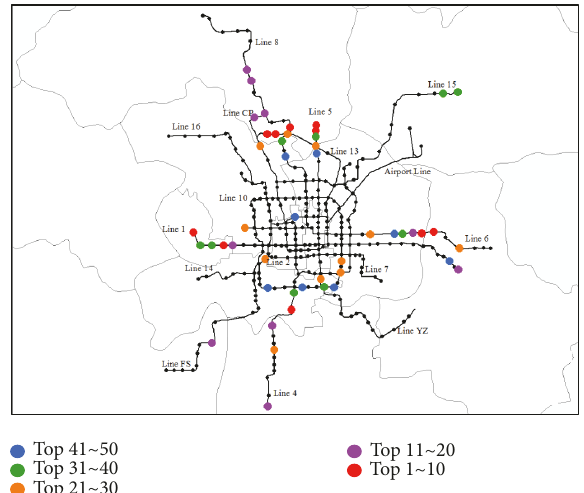
Figure 13: The top 50 stations with the largest number of shifted